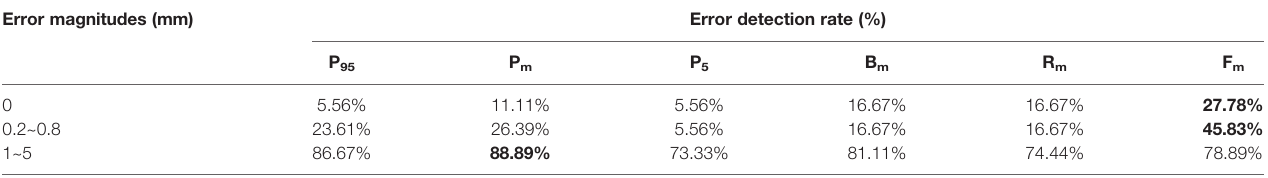
Error magnitudes